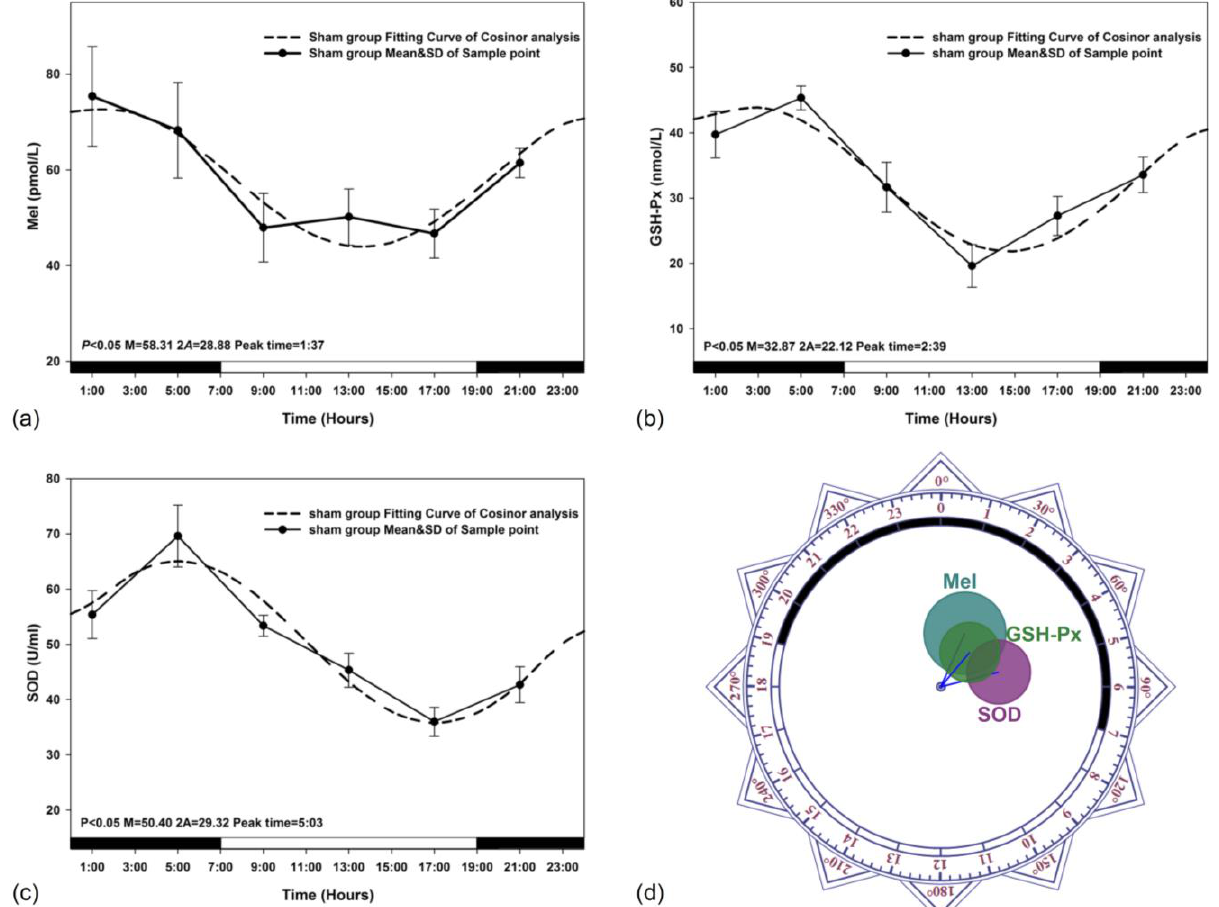
Figure 3. Sham-exposed rats. The best-fitting curves (means ± standard error) determined for Mel ( a ); GSH-Px ( b ) and SOD ( c ); Y-axis represents Mel/GSH-Px/SOD concentration in the plasma; x-axis represents the Time during the 24 h light-dark cycle; ( d ) Zero-amplitude test for circadian rhythms of Mel, GHS-Px and SOD concentration. The circles represent the 95% joint confidence intervals of amplitude and acrophase. The pole (zero-point) of the polar coordinate was not overlapped by the circles, namely the zero amplitude hypothesis was rejected because of p < 0.05, which indicates a distinct circadian rhythmicity of Mel, GSH-Px and